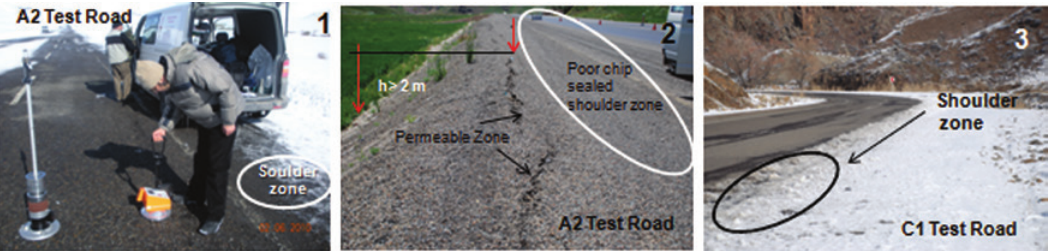
and C test roads (1, 2, 3); high slope of embankment and permeable zones of shoulder’s surface at 2 1